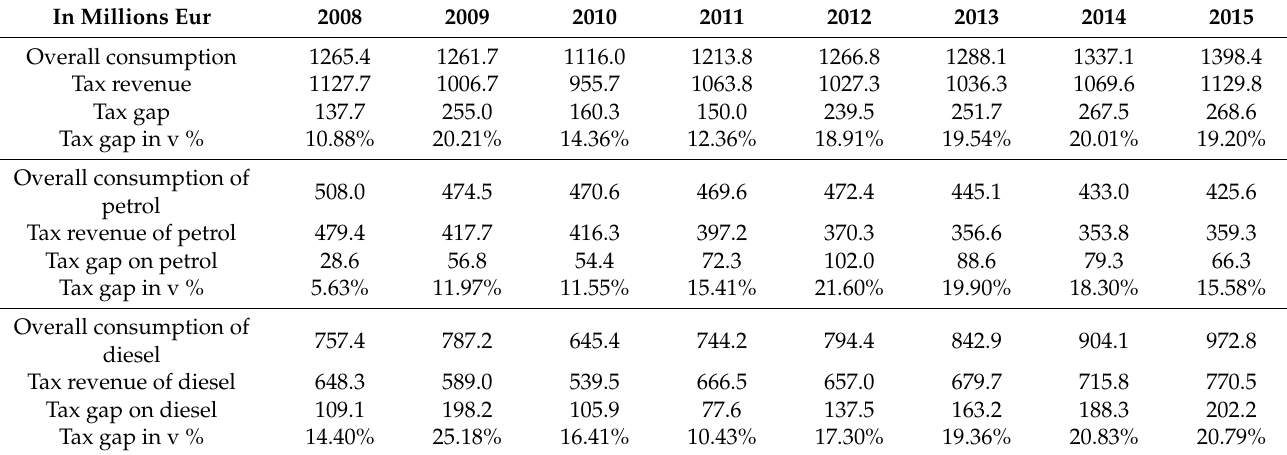
Table 2. The tax gap in % of the overall consumption and in EUR million classified into diesel and petrol—high risk level rate. In Millions Eur